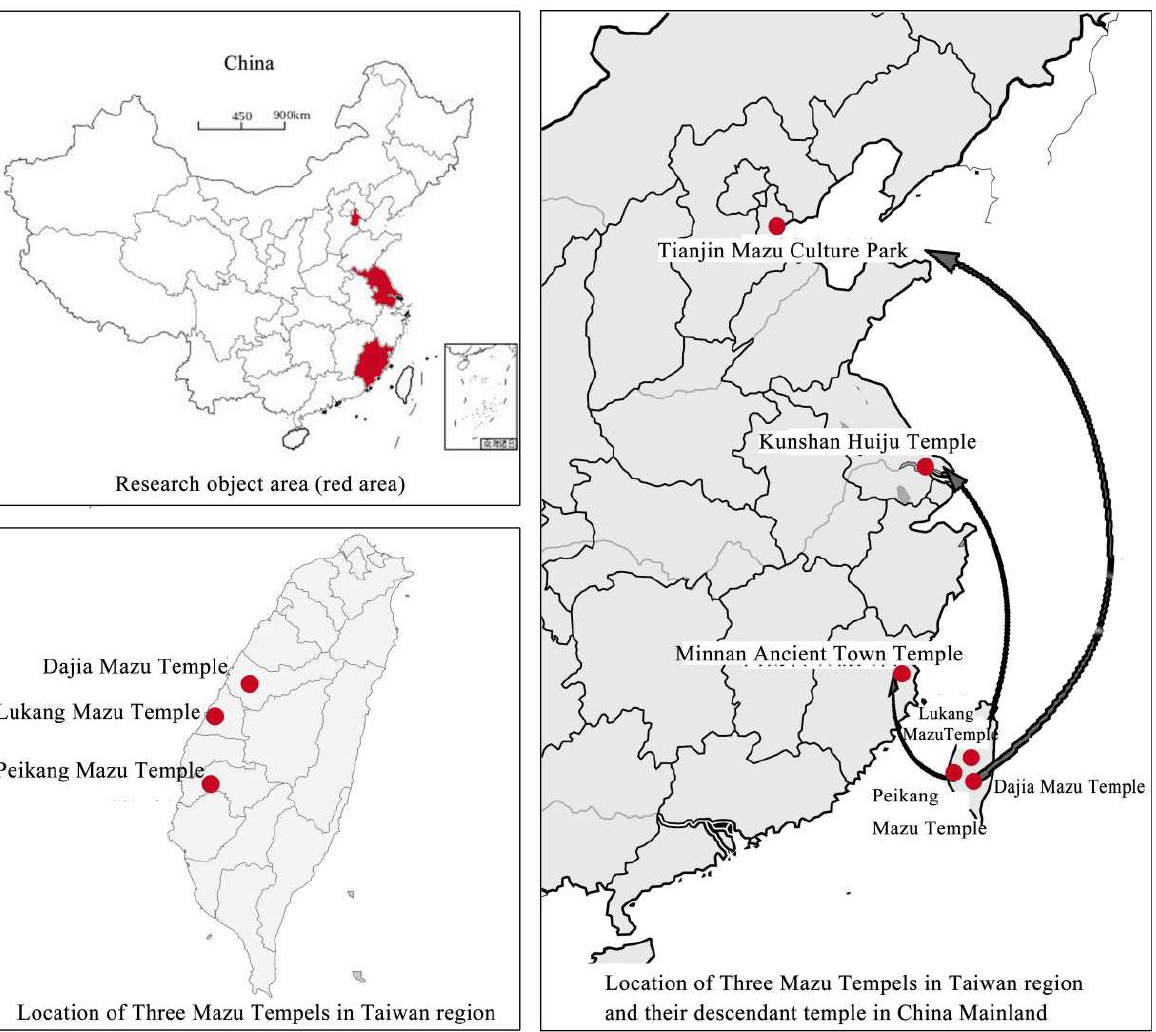
Figure 2. Location and migration map of three Mazu temples from Taiwan to mainland China. Source: Compiled by the